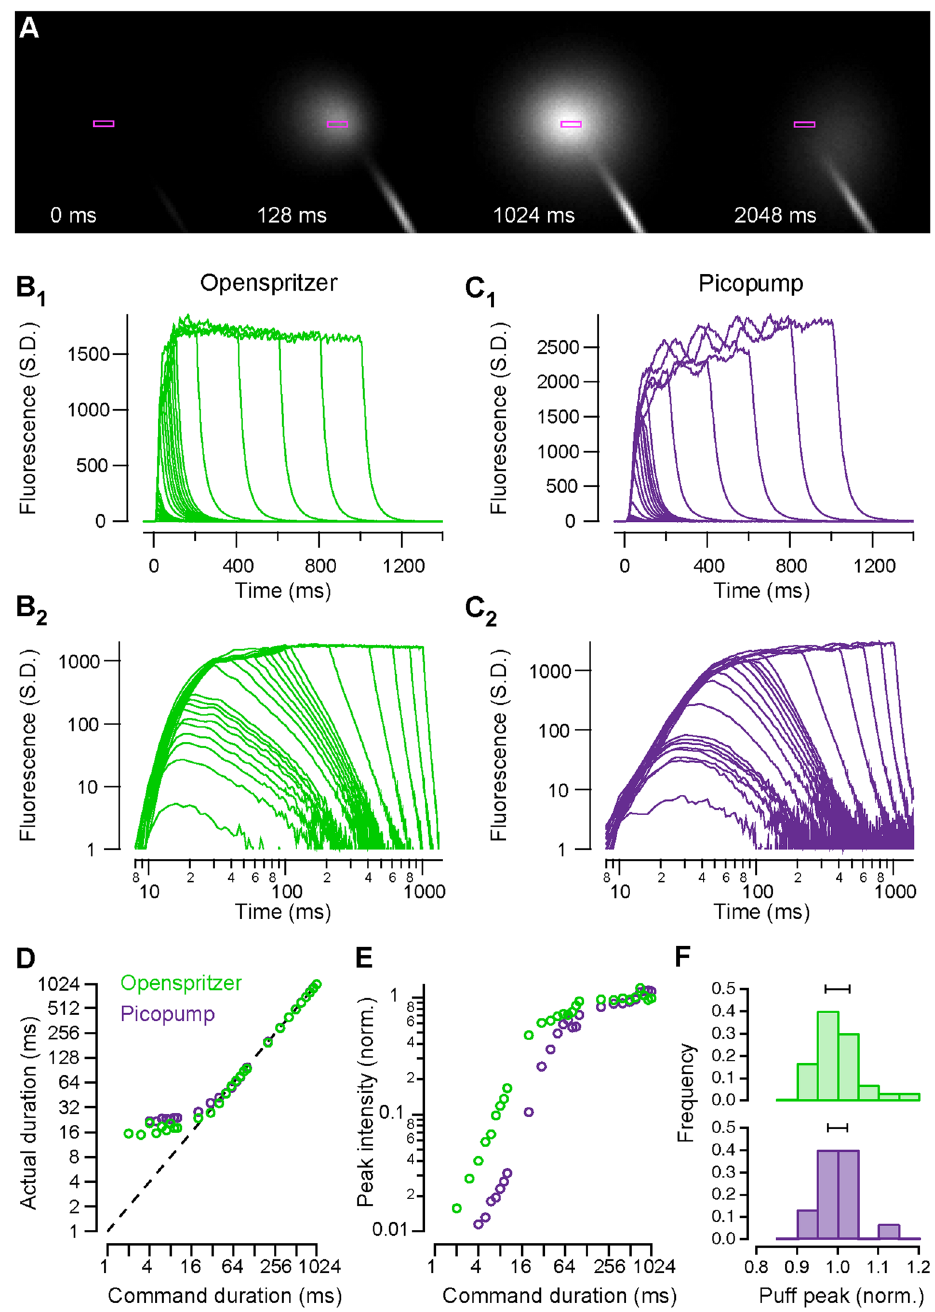
Figure 2. Two-photon imaging of fluorescent puff dynamics demonstrates comparable performance between Openspritzer and Picopump, a commercial alternative. Reducing the scanning motion of a two- photon scanning microscope to movements within the point spread function enabled time-precise imaging of fluorescent pulses emitted by either the Openspritzer or the Picopump. ( A ) Scanning image of a 100 ms Openspritzer pulse. ( B 1 and B 2 ) A train of 27 puffs generated by Openspritzer ranging from 2 ms to 1000 ms command duration. ( B 1 ) is a linear plot and ( B 2 ) is a log-log plot of the same data. ( C 1 and C 2 ) A train of 25 puffs generated by Picopump ranging from 4 ms to 1000 ms command duration. ( C 1 and C 2 ) are linear and log-log plots, respecively. The original command durations were in 3 groups of 1 to 9 ms in 1 ms intervals, 10 to 90 ms in 10 ms intervals and 100 to 1000 ms in 200 ms intervals. ( D ) Puff duration, measured from the onset of the initial phase of the fluorescent pulse to decay onset plotted against command duration. ( E ) Normalised maximum peak intensity plotted against command duration, normalised to the average maximum value of the last nine puffs. ( F ) Histogram of the normalised maximum peak intensities of a train of thirty 10 ms puffs for Openspritzer and Picopump (black bars indicate SD). Openspritzer in green, Picopump in purple ( B–F ). All trials were taken with the same